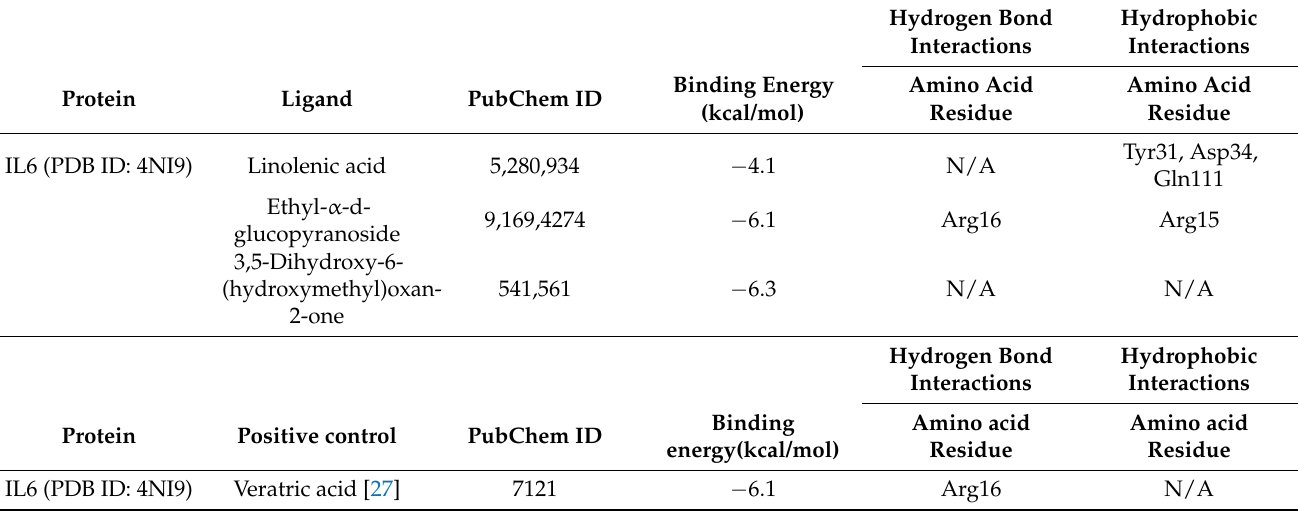
Table 5. The binding energy of potential compounds and a positive control on IL6 (PDB ID: 4NI9).